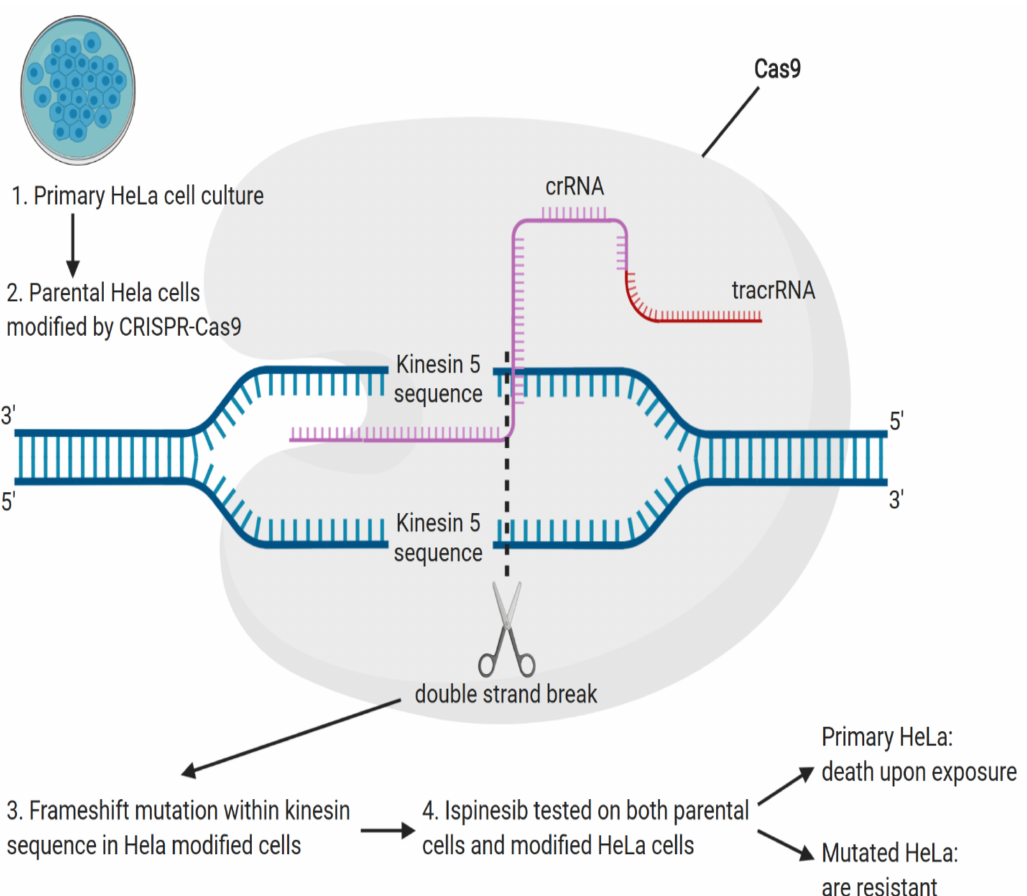
Figure 3. Following PCR confirmation of Kinesin 5 mutation in resistant cells, the primary culture of HeLa cell culture (parental) was plated (1). The parental cells were isolated and modified by CRISPR / Cas9 nickase (2) targeting the kinesin 5 sequence and yielding a frameshift mutation that resulted in HeLa clone daughter cells (3). Ispinesib treatment was performed on both parental and daughter cells (4). Parental cells died upon exposure, whereas daughter cells remained viable